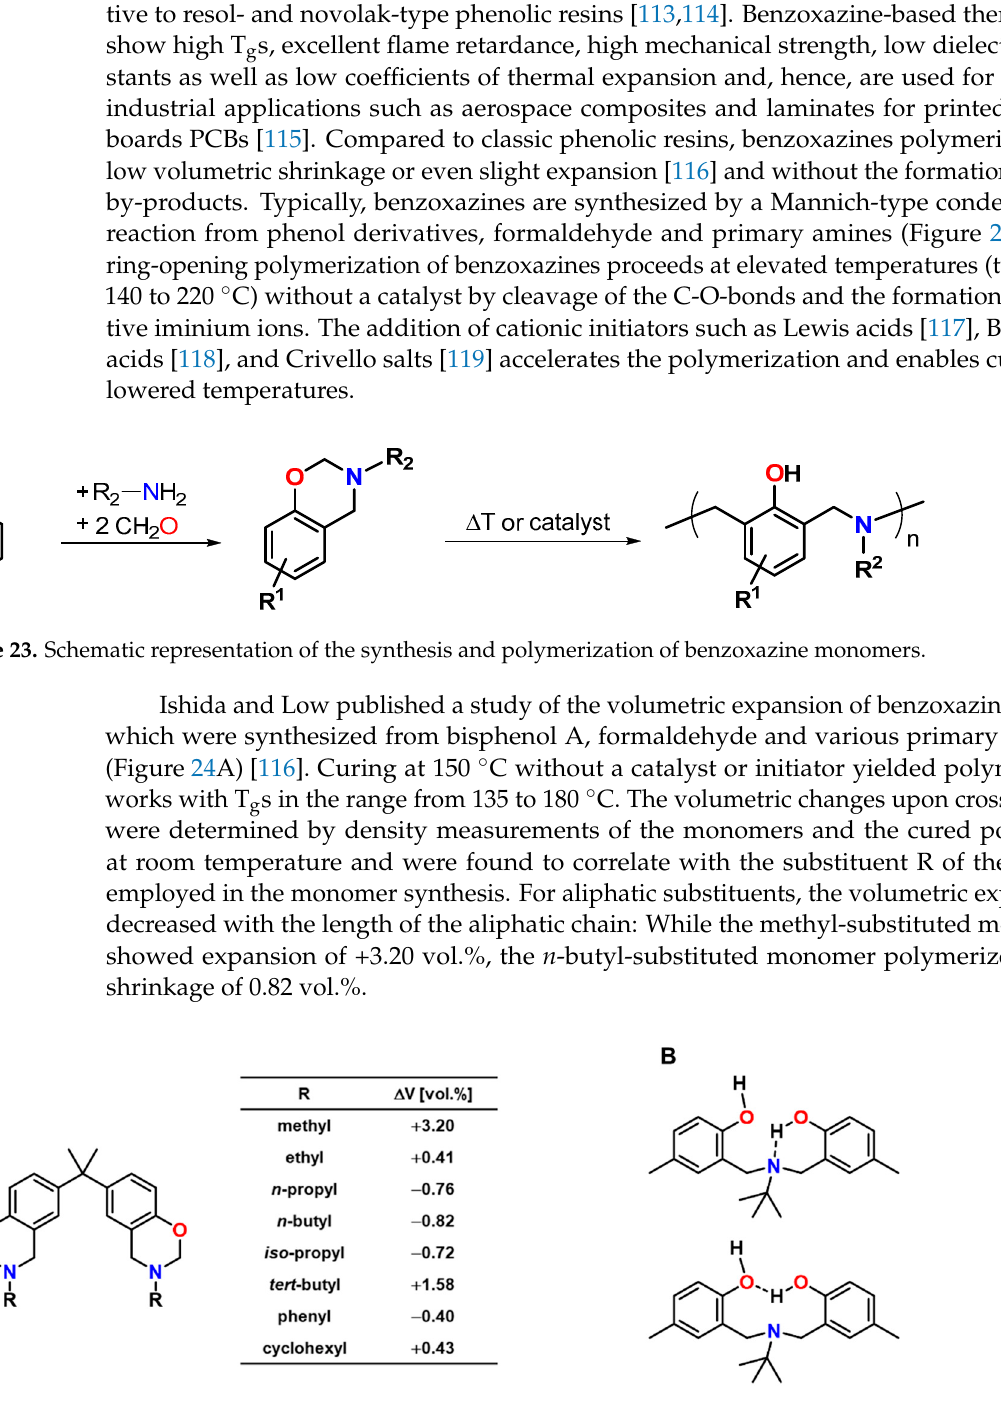
Figure 24. A : Volumetric changes of bisphenol A-based benzoxazines with different substituents R at the nitrogen atom. B : Schematic representation of possible hydrogen intramolecular bonds in N , N -bis(3,5-dimethyl-2-hydroxybenzyl)methylamine as model compound for benzoxazine-based resins.